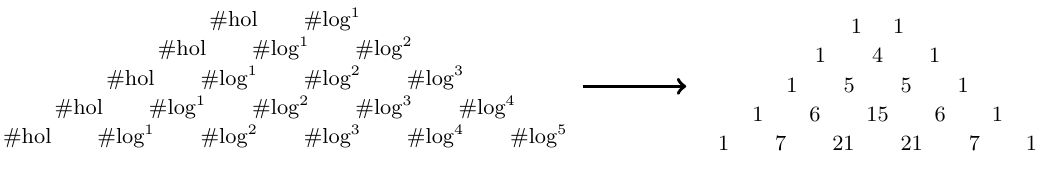
Figure 4 . The number of logarithmic solution for the non equal mass case for l = 2 , . . . , 6